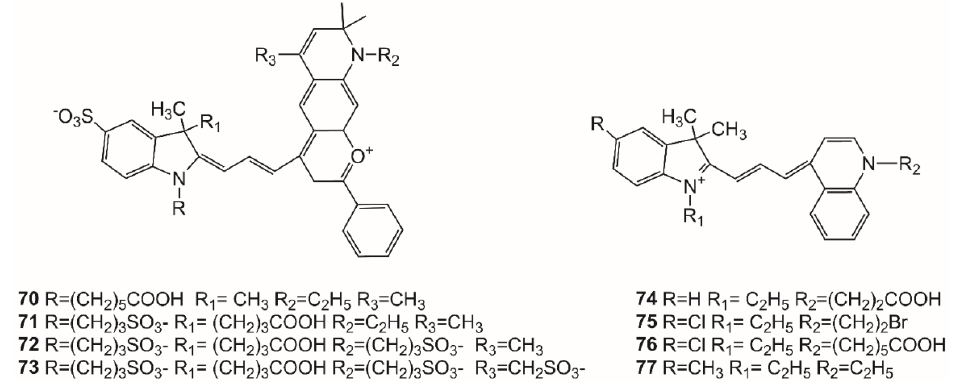
Figure 16. Structures of unsymmetrical trimethine cyanines 70 – 77 .